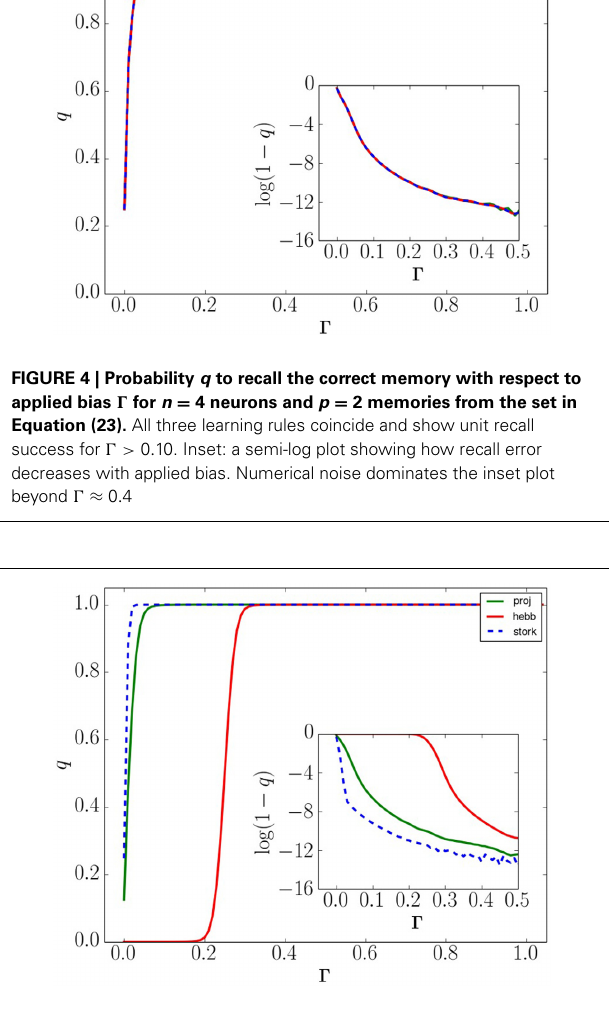
FIGURE 5 | Probability q to recall the correct memory with respect to applied bias (cid:3) for n = 4 neurons and p = 3 memories from the set in Equation (23). The Hebb rule has strong dependency on (cid:6) due to memory interference while the Storkey and projection rules accommodate interference better. Inset: a semi-log plot showing how recall error decreases with applied bias. Numerical noise dominates the inset plot beyond (cid:6) ≈ 0 .